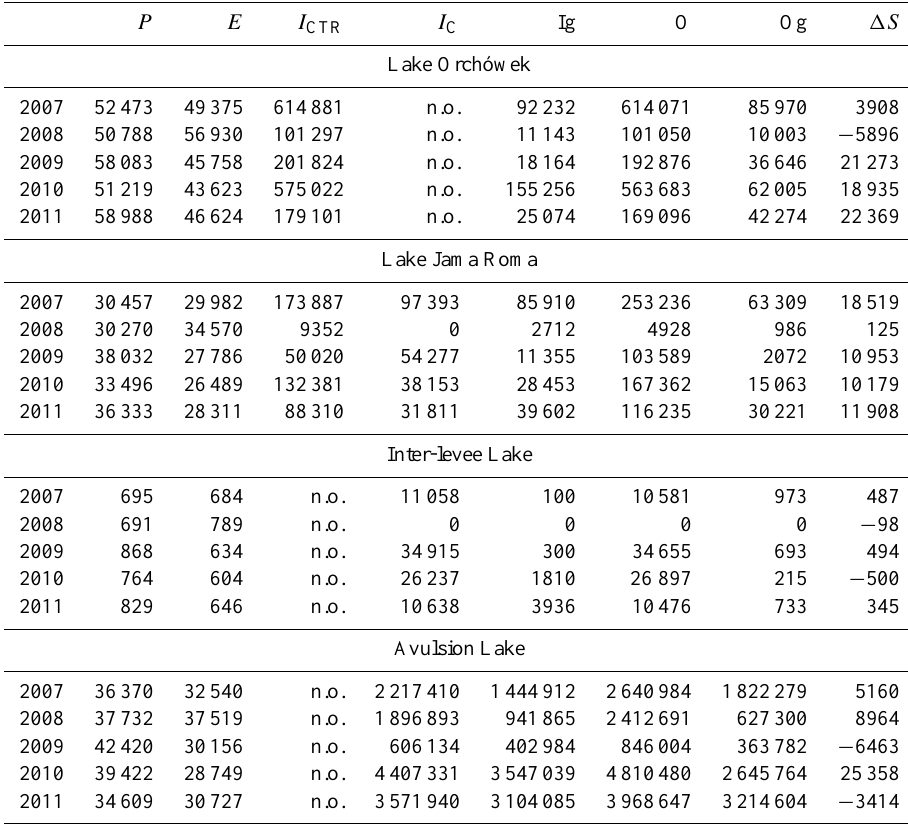
Table 2. Water balance elements of the lakes under study (m 3 yr − 1 )